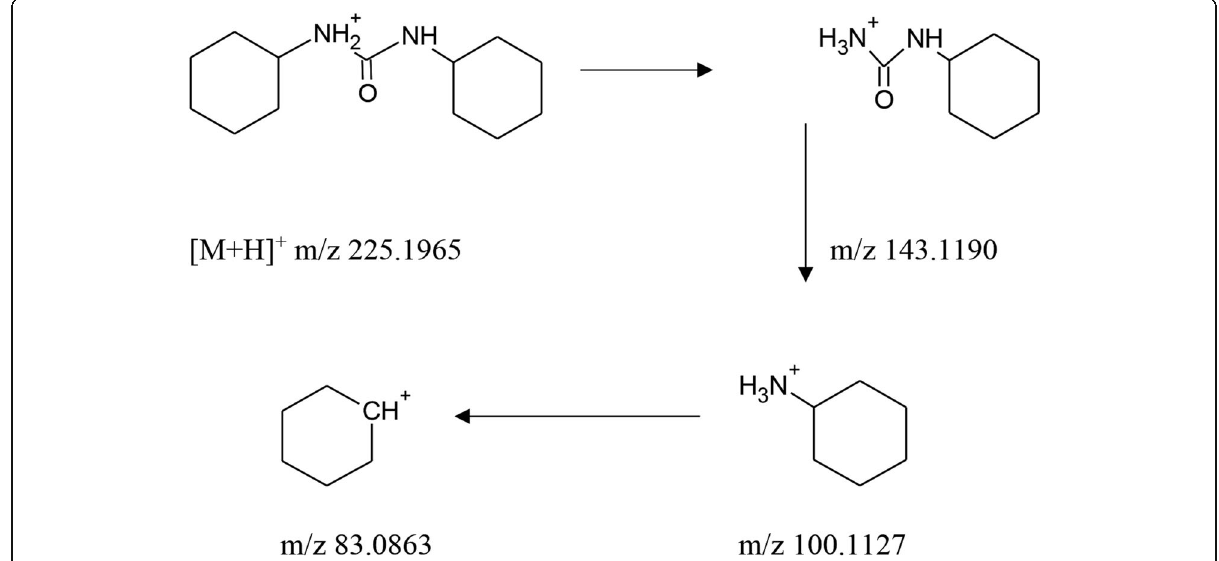
Fig. 5 Proposed chemical structure of dicyclohexyl urea and its fragment ions with the respective exact